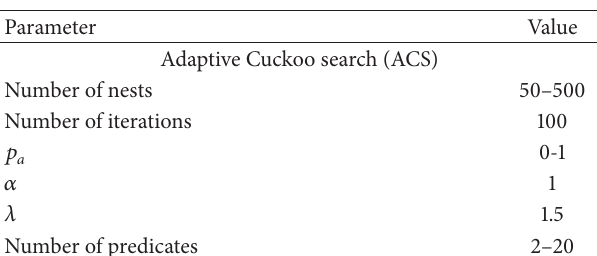
Table 1: Parameters and their values for adaptive Cuckoo search algorithm.